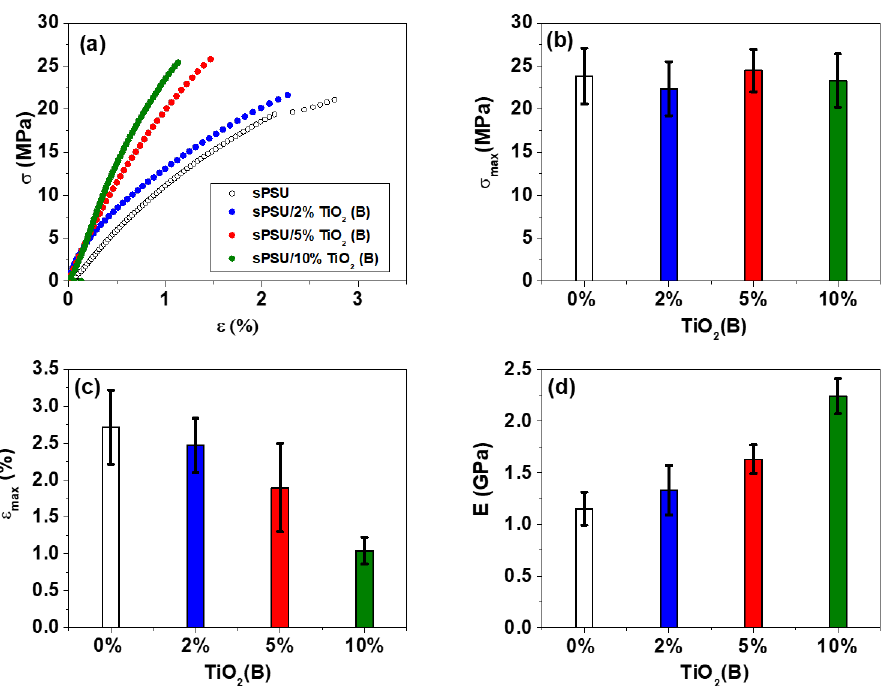
Figure 7. ( a ) Stress (σ)-strain (ε) curves and values of ( b ) maximum stress (σ max ), ( c ) elongation-to- break (ε), ( d ) Young modulus (E) for sPSU and sPSU/x% TiO 2 (B) membranes (x = 2; 5 and 10).